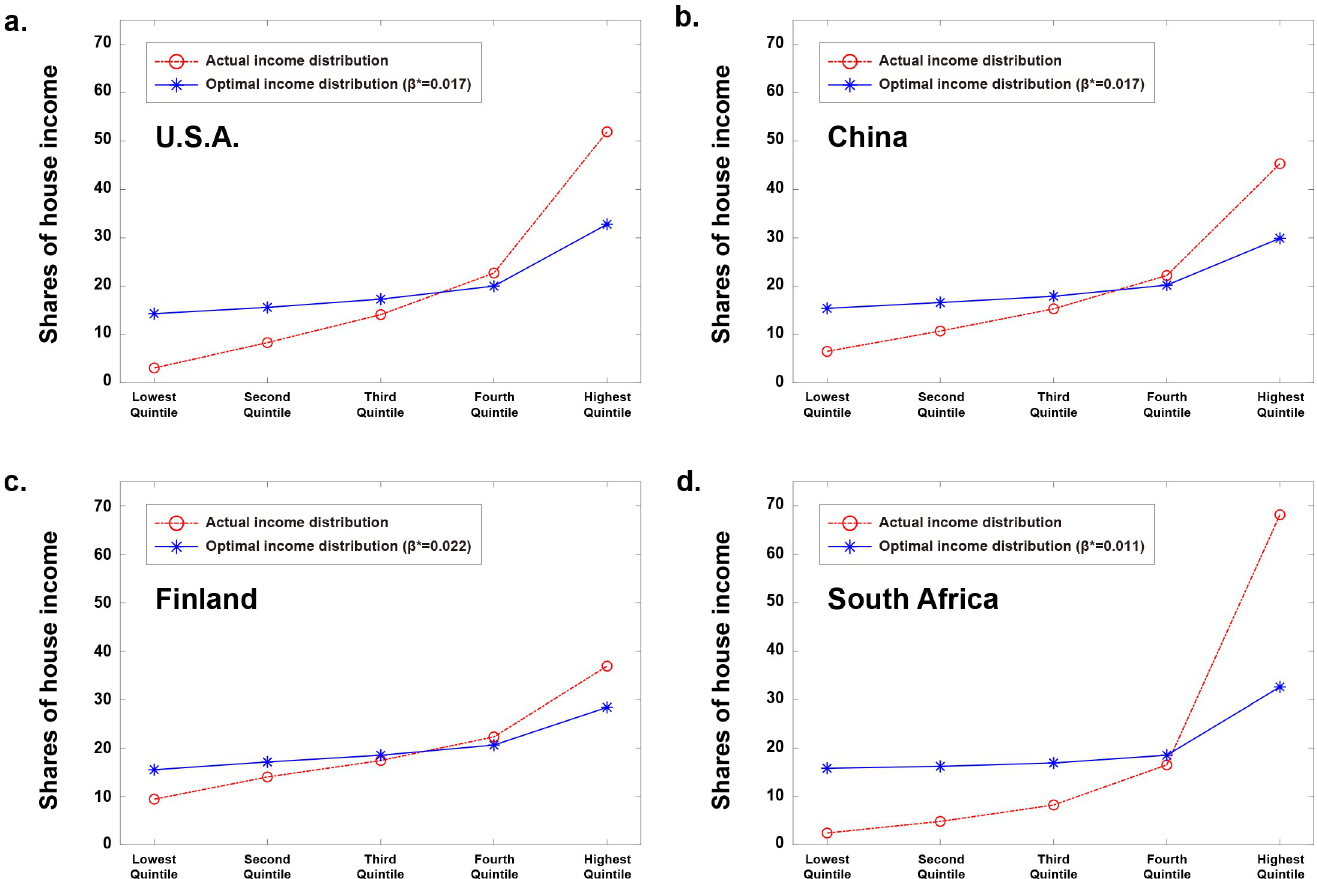
Fig 5. Actual and optimal income distributions in four countries. Compared to the actual income distribution, the optimal income distribution shows higher income in the lower quintiles and less income in the highest quintile.